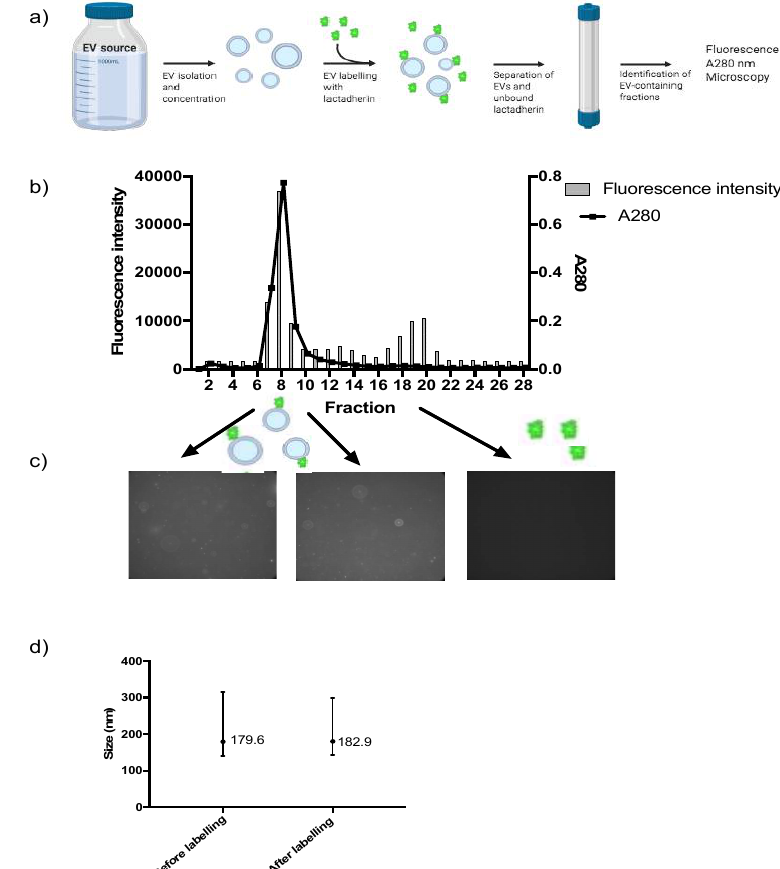
Figure 1. Labelling and identification of labelled extracellular vesicles (EVs). The workflow for labelling the EVs is shown in ( a ), ( b ) shows representative data of the total fluorescence in each fraction after separating EVs and unbound lactadherin using SEC. Two nicely separated peaks could be identified. The fractions containing EVs were spectrophotometrically determined by measuring absorbance at 280 nm, where EVs scatter light. Afterwards, fractions containing labelled EVs were pooled and used for experiments. ( c ) Confocal fluorescence microscopy confirmed the presence of EVs labelled with Alexa Fluor-conjugated lactadherin bound to in the fractions 7–9 identified from ( b ) and the absence of EVs in fraction 18–20 (100 × magnification). ( d ) Particle size distribution was determined using the Nanoparticle Tracking Analysis on EVs after purification from milk and on labelled EVs after concentration and incubation with lactadherin. Data show the D10, mode ( • ) and D90 mean sizes. N = 5. Values are means ± SD.